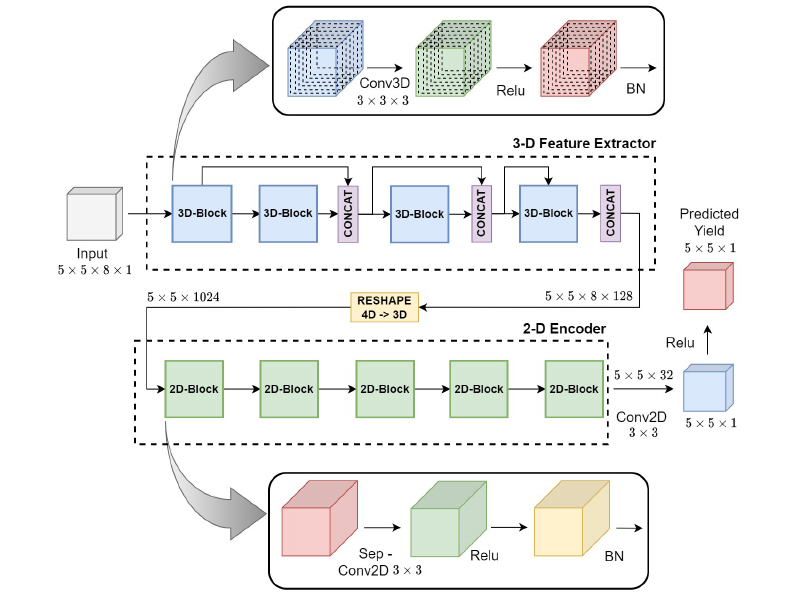
Figure 3. Hyper3DNetReg architecture with a 5 × 5 × 8 × 1 input and a 5 × 5 × 1